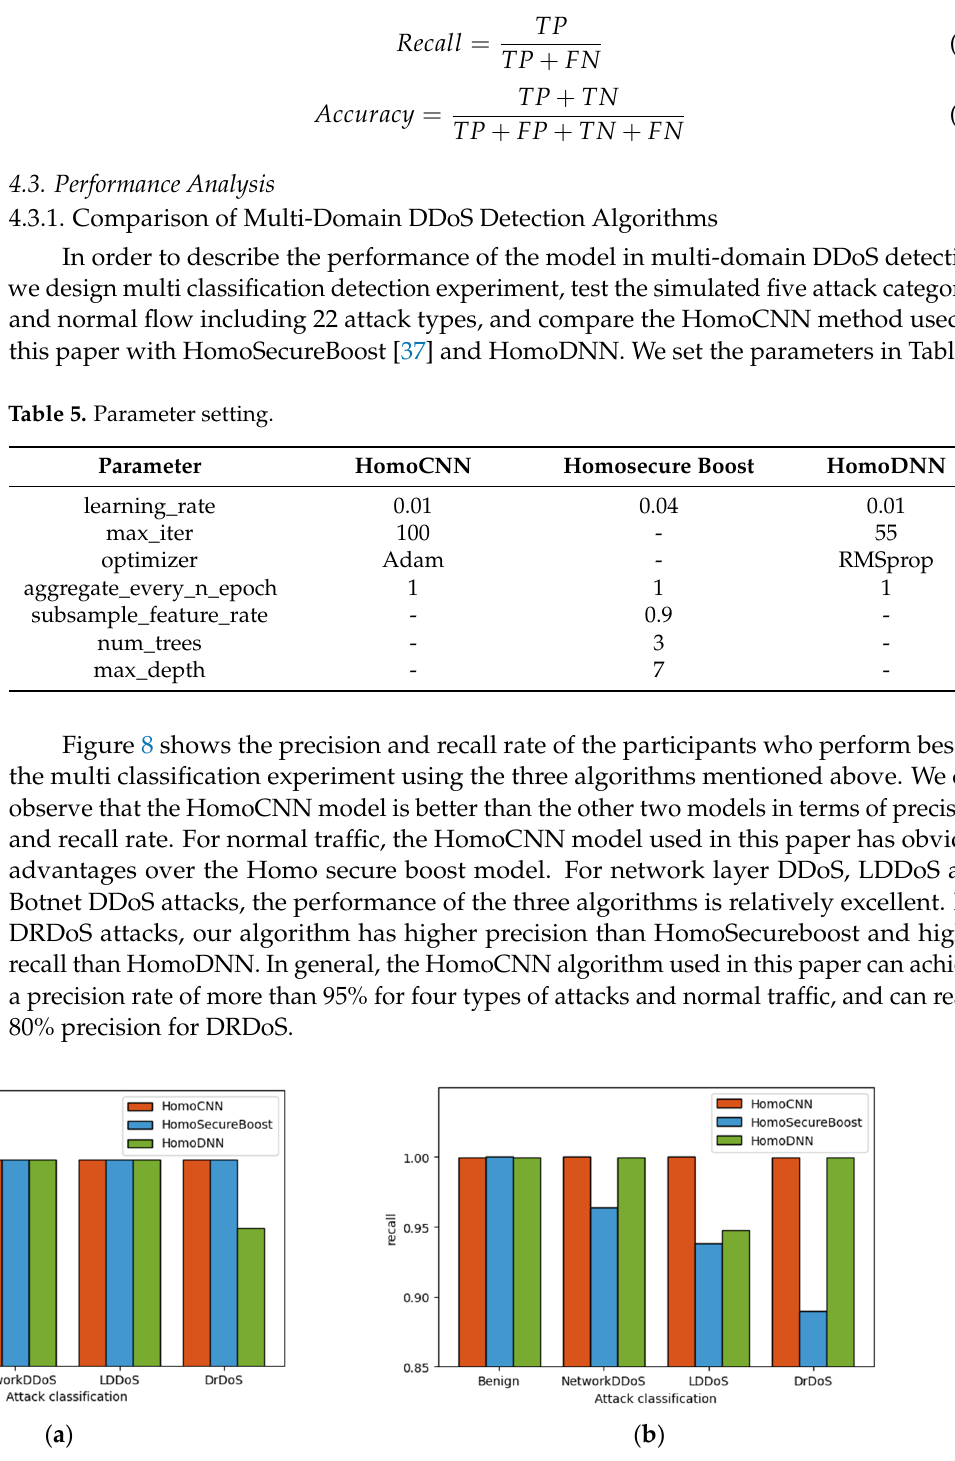
Figure 8. Comparison of different methods: ( a ) Comparison of precision; ( b ) Comparison of recall.